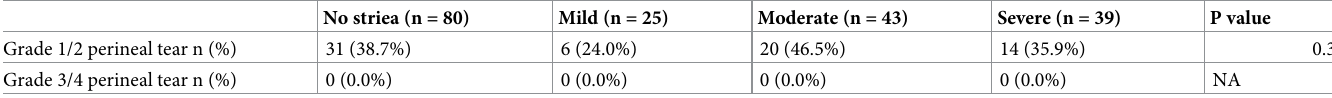
Table 4. Differences in rates of perineal tears between women with and without SG, divided by